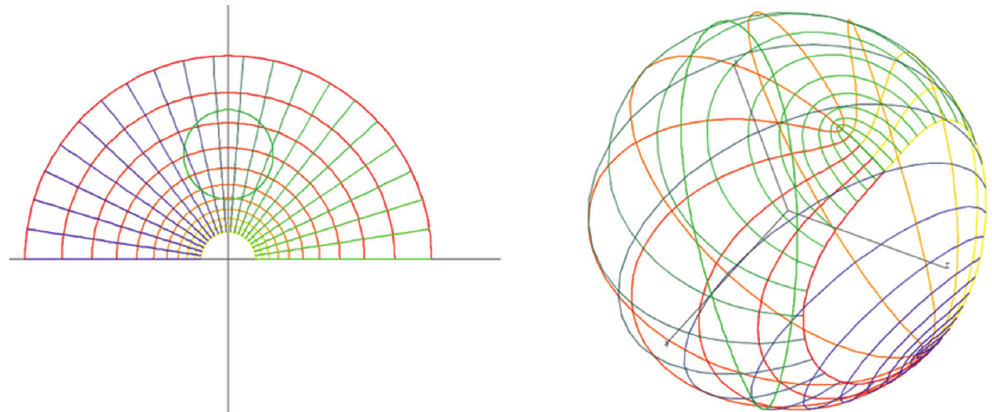
Fig. 1. The color-coded family of spherical conics and its corresponding domain